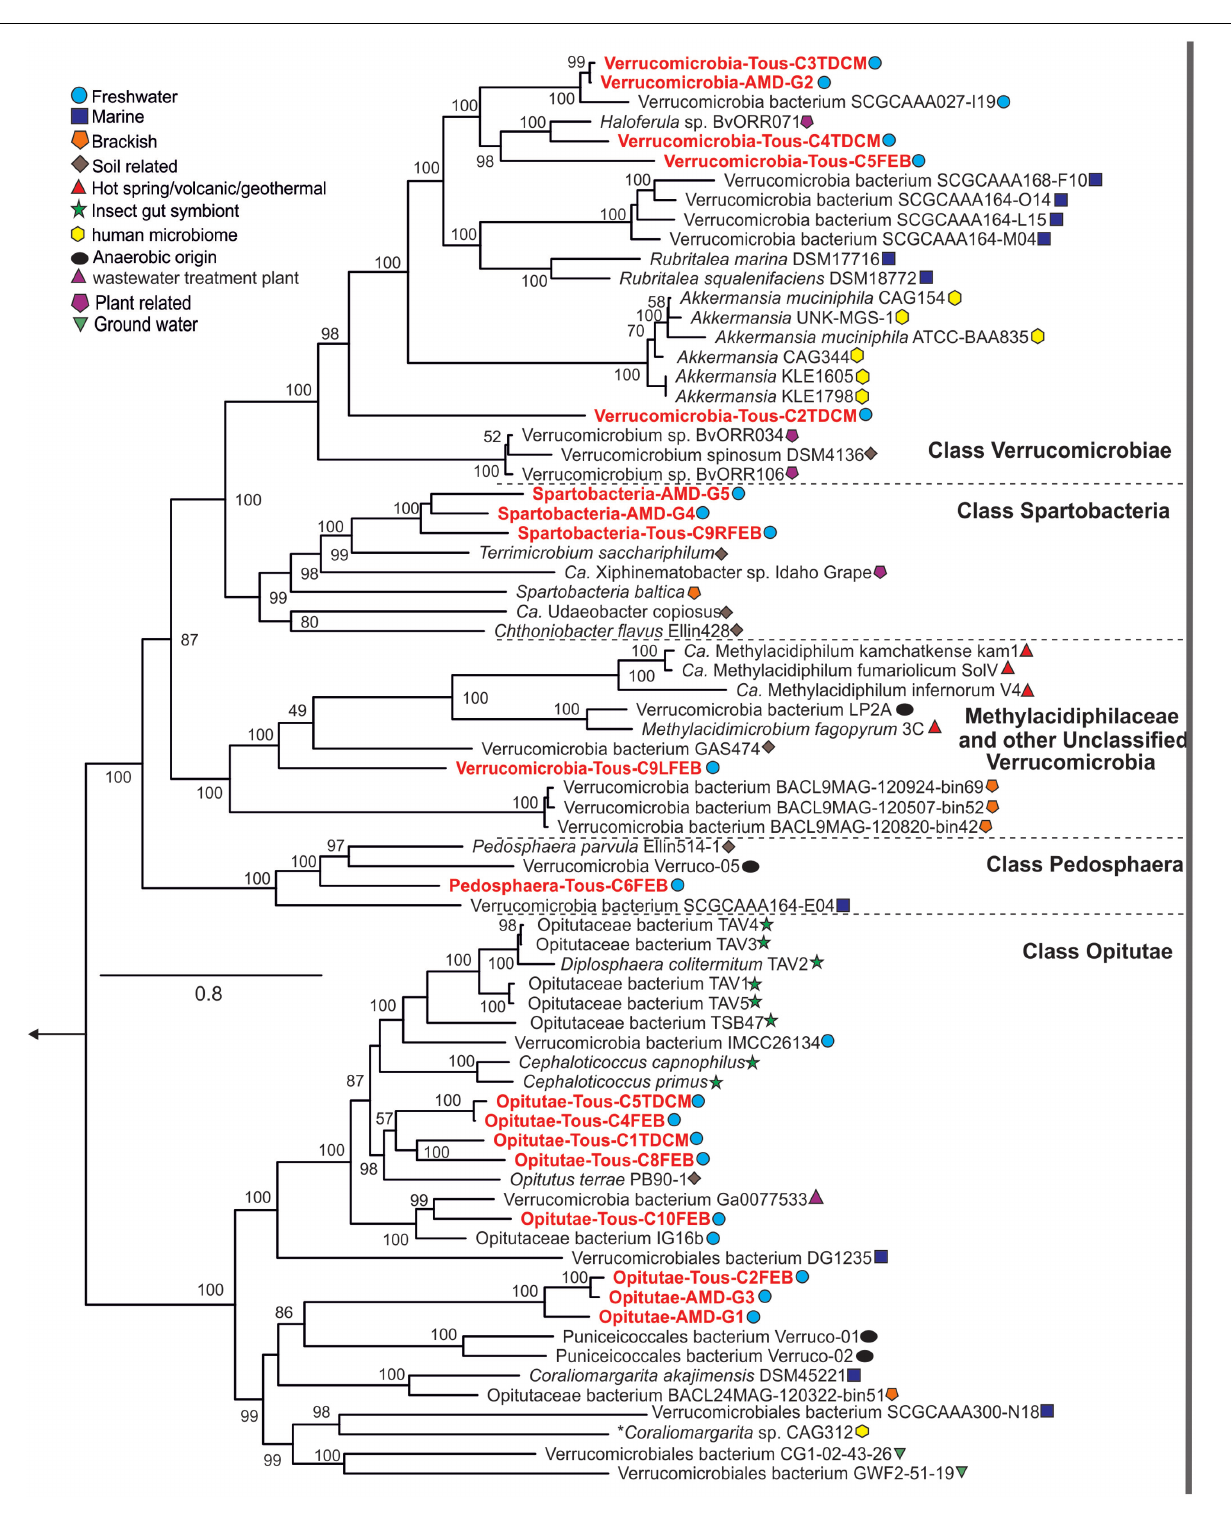
FIGURE 1 | Phylogenomics of the entire phylum Verrucomicrobia . Reference isolates, MAGs, and SAGs from multiple habitats and classes (Opitutae, Verrucomicrobiae, Spartobacteria, Pedosphaera, and Unclassified) and subdivisions are represented in the protein concatenated tree. Tous and Amadorio MAGs presented in this study are red